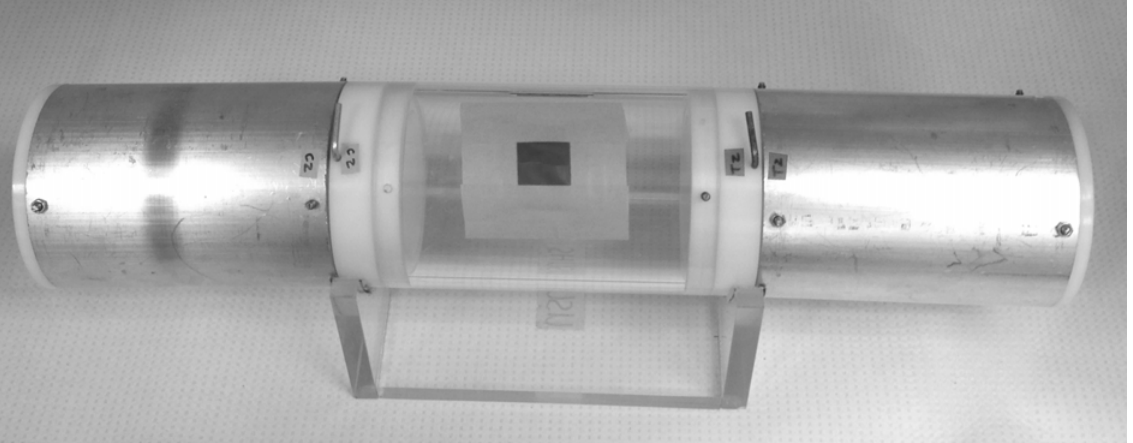
Fig 1. The high throughput screening system (HITSS) spatial repellency assay (SRA). The treatment chamber (right hand metal cylinder) is covered internally by nylon organdy netting treated with transfluthrin dissolved in 100% acetone. The control chamber (left hand metal cylinder) contains netting treated with acetone only. Cohorts of 20 mosquitoes are introduced into the central (clear) chamber and directional flight behaviors are observed (See text, Adapted from Grieco, et al. 2007. J Am Mosq Control Assoc 2005, 21:404 – 411).